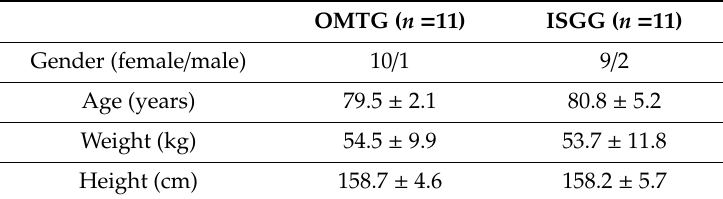
Table 1. General characteristics of the outdoor multisurface terrain group and the indoor solid ground